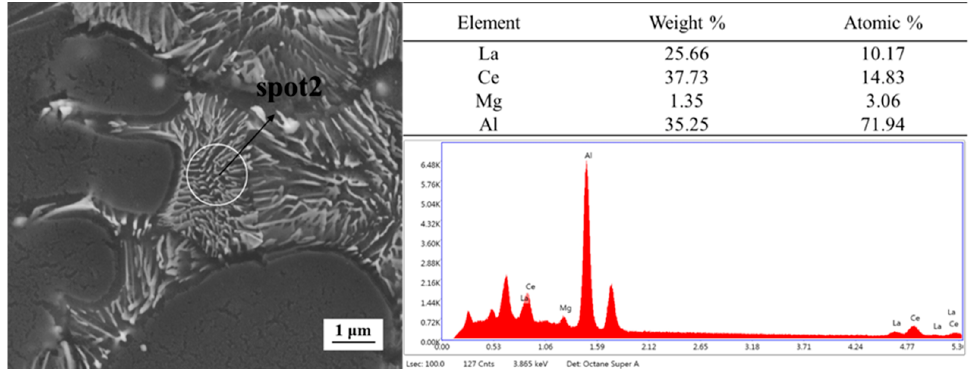
Figure 5. SEM image and the representative point EDS spectrum along with the analysis results of the acicular eutectic phases in the Mg-4Al-4 (La, Ce)-1Sm alloy.